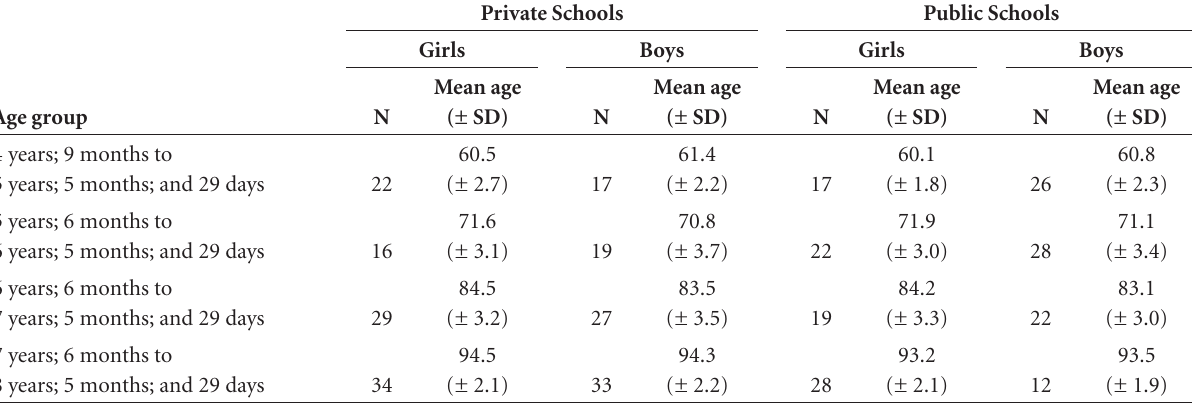
Table 1. Mean age (in months) and number of girls and boys as functions of age group and type of school.